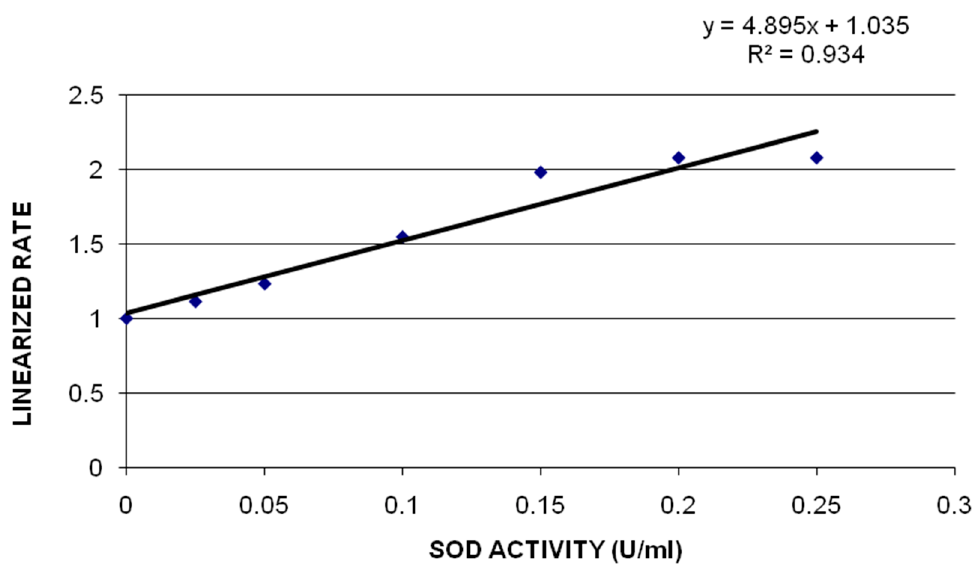
Figure 5. SOD standard curve where y-axis represents the linear rate of absorbance (450 nm) and x axis represents the SOD activity of reference standard, bovine erythrocyte SOD, expressed in U/ml.